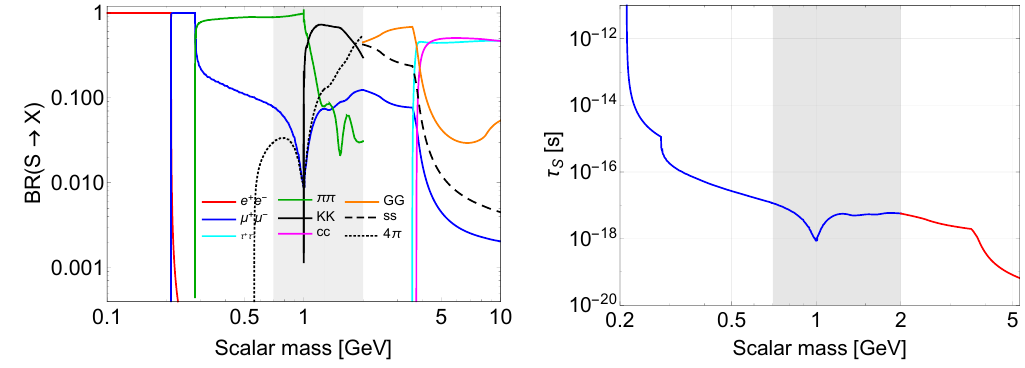
Figure 10 . Left panel: branching ratios of decays of a scalar S as a function of its mass. For decays into hadrons up to m S = 2 GeV we used results from [32], while for decays into hadrons in the mass range m S > 2 GeV we used perturbative decays into quarks and gluons (see section H.2). In order to match these two regimes, we added a toy-model contribution to the total decay width that imitates multi-meson decay channels, see eq. (3.2). Right panel: the lifetime of a scalar S as a function of its mass with the mixing angle (cid:18) 2 = 1. Solid blue line denotes the lifetime calculated using decays into leptons, kaons and pions from [32] and (cid:12)ctitious multi-meson channel, see eq. (3.2), while solid red line | the lifetime obtained using decays into quarks and gluons within the framework of perturbative QCD. The (cid:12)lled gray regions on the plot correspond to the domain of the scalar masses for which there are signi(cid:12)cant theoretical uncertainties in hadronic